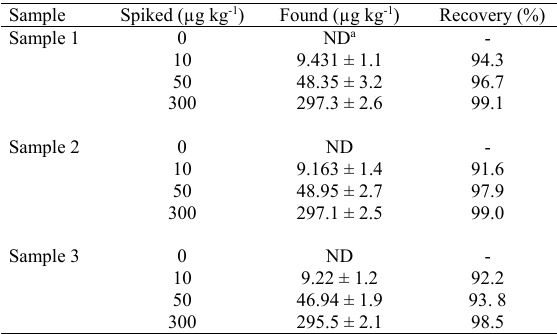
Table 3 Determination of ZEN in spiked wheat samples (n=3). Table 3. Determination of ZEN in spiked wheat samples (n=3).